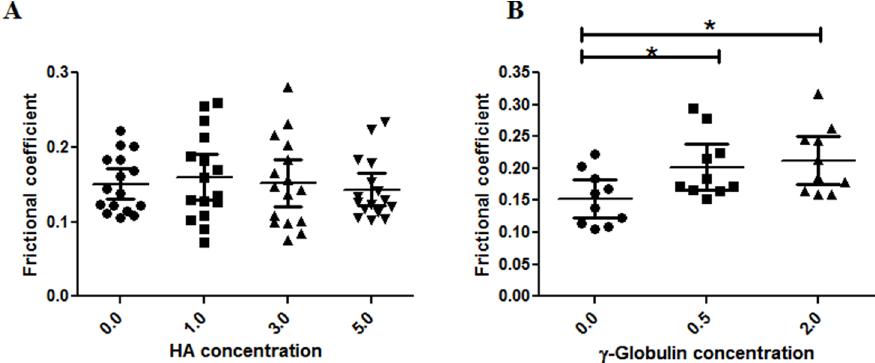
Figure 8. AFM measured frictional coefficients of early OA cartilage measured in a range of (A) HA (no of observation 5 16) and (B) c –globulin (no of observation 5 10) concentrations. In case of HA, no significant changes in frictional coefficient were observed. c –globulin shows concentration based effect on frictional coefficient. The frictional coefficient values are from measurements at different locations on two samples of normal human cartilage from a single femoral head. Vertical bars represent the 95% of confidence interval. *P ,